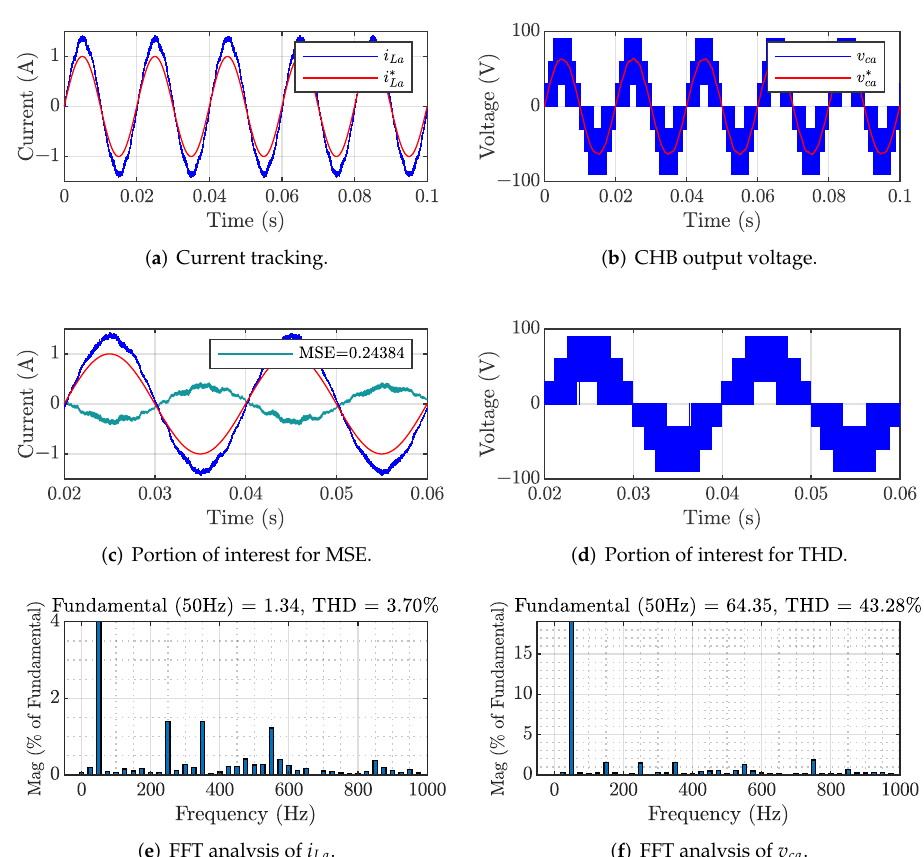
Figure 5. Simulation results for phase a in the presence of parametric